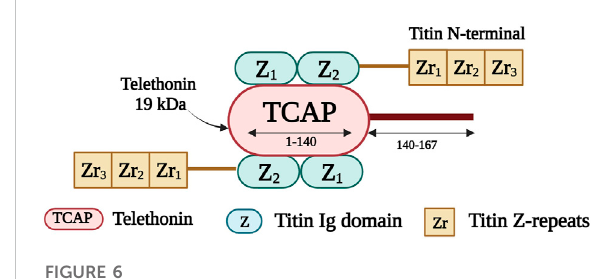
FIGURE 6 Schematic representation of the interaction taking place between the fi rst 140 residues of telethonin and the fi rst two titin Ig domains (Z1 and Z2). Created with